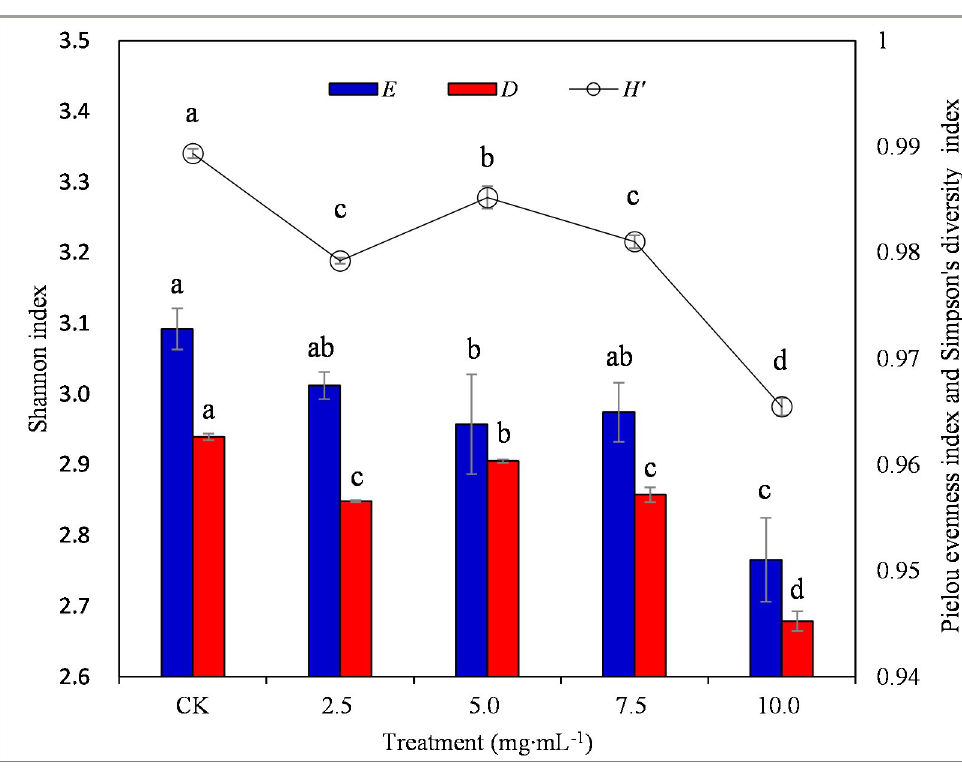
Fig 4. Diversity and evenness indices of soil microbial communities. H’ : Shannon index; D : Simpson diversity index; E : Pielou evenness index. Values represent means ± standard deviation ( n = 15). Significant differences between treatments are indicated with lowercase letters (a-c; P < 0.05).